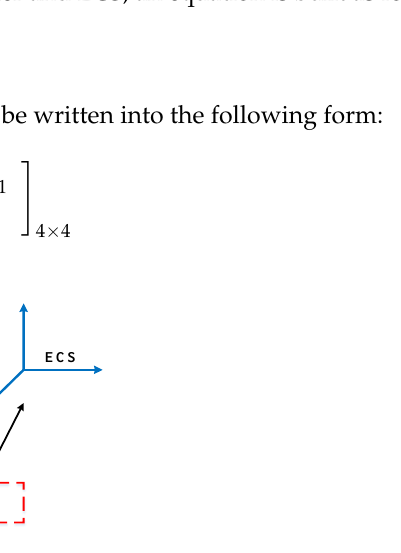
Figure 5. Hand-eye calibration.